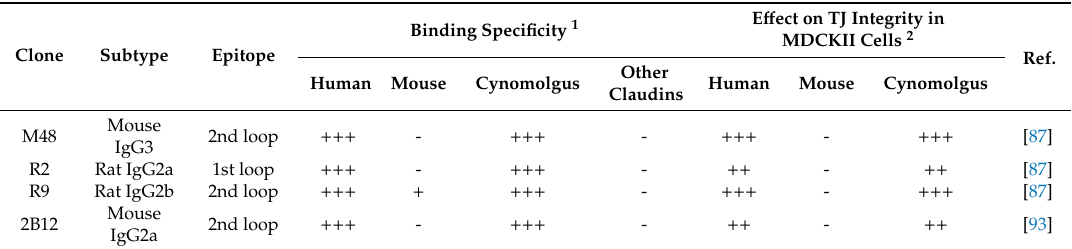
Table 1. Summary of monoclonal antibodies that recognize the extracellular region of human claudin-5.